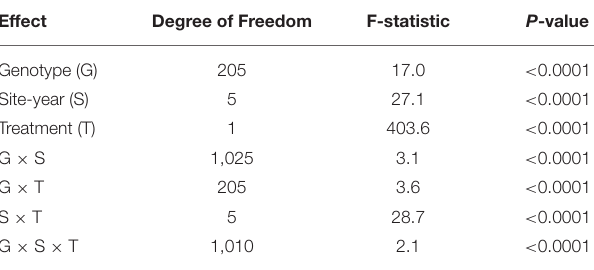
TABLE 2 | Analysis of variance (ANOVA) for